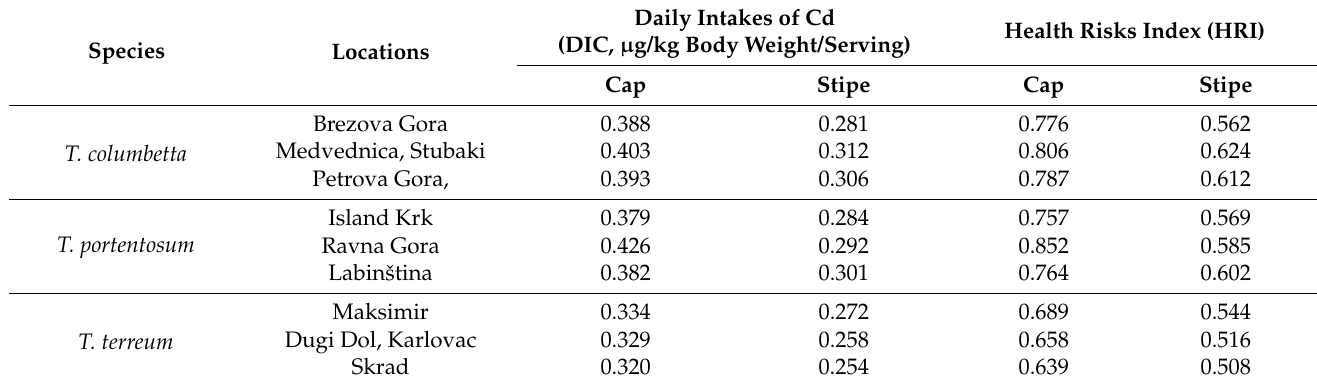
Table 4. Daily intakes of Cd and health risk index in wild edible Tricholoma spp. mushrooms.